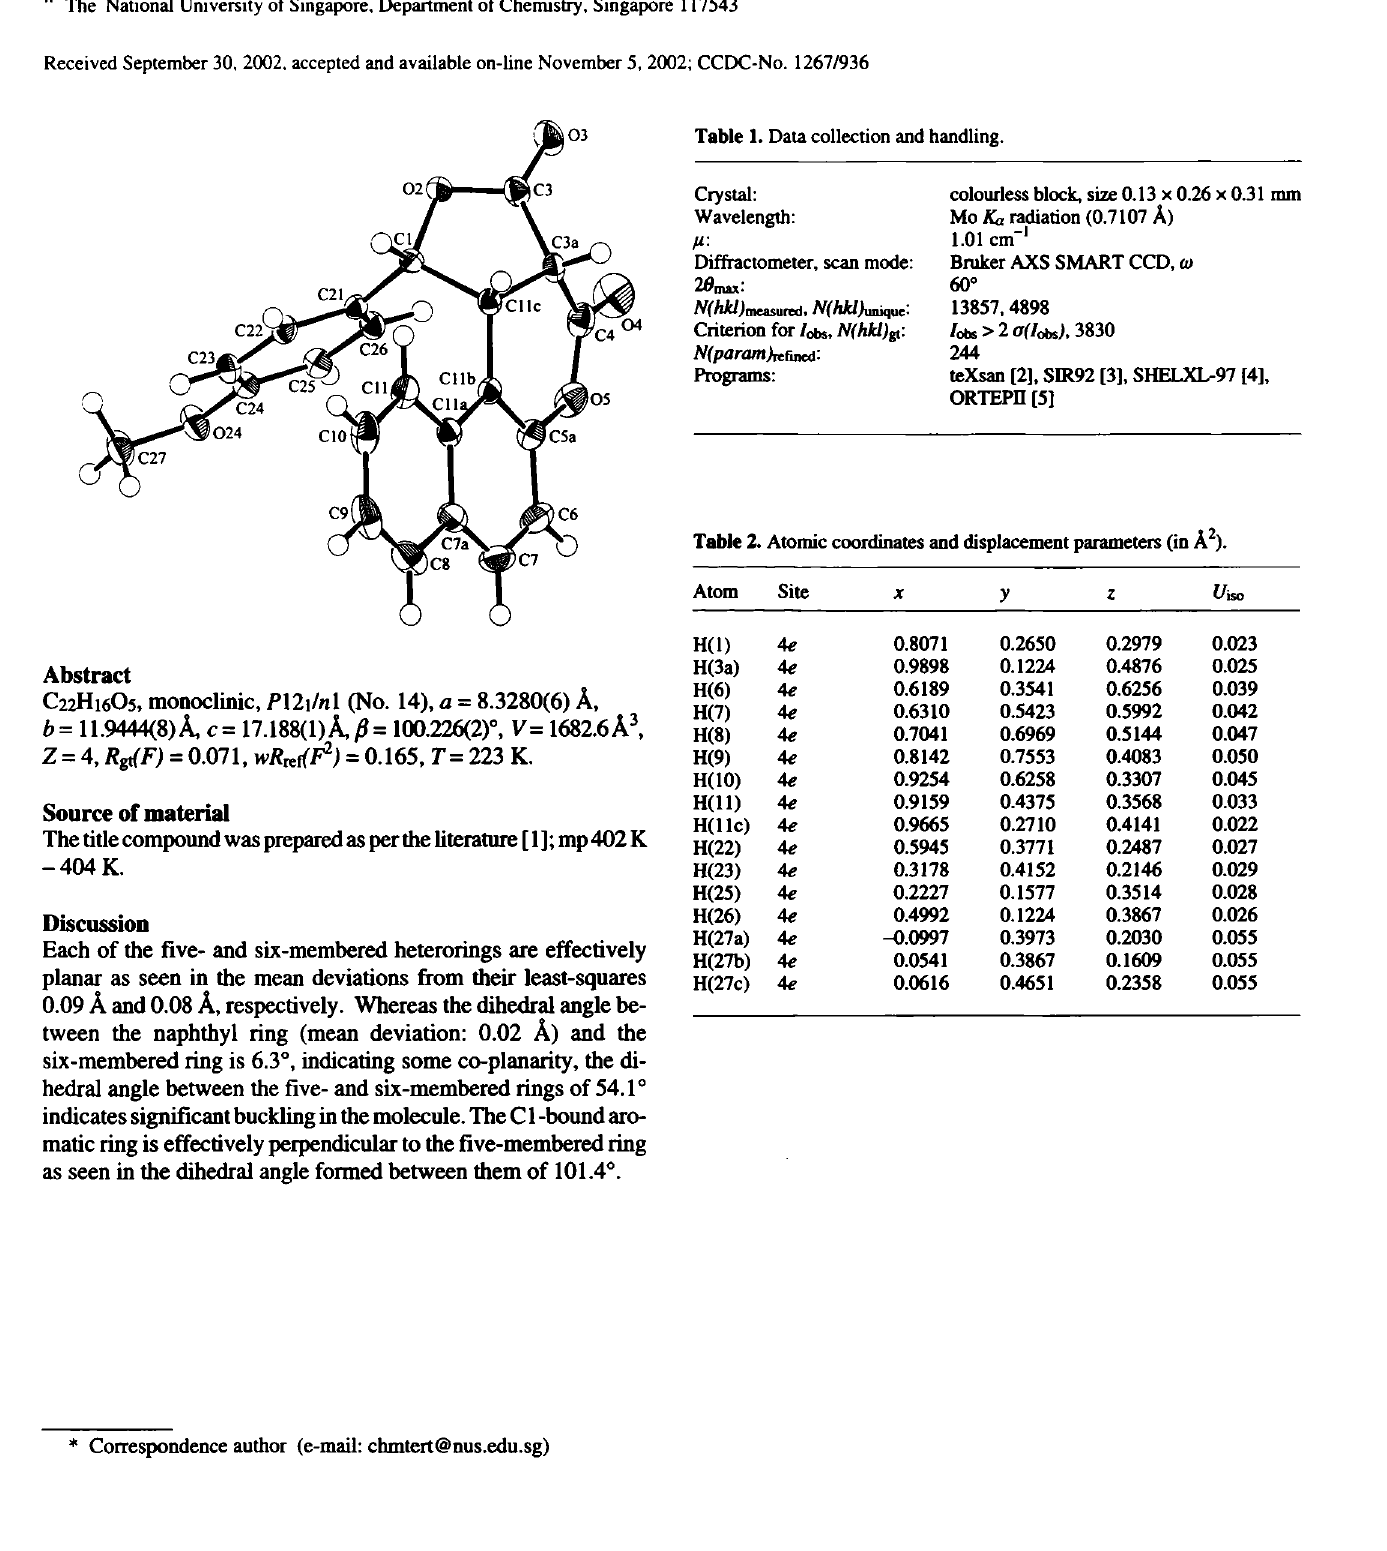
Table 1. Data collection and handling.